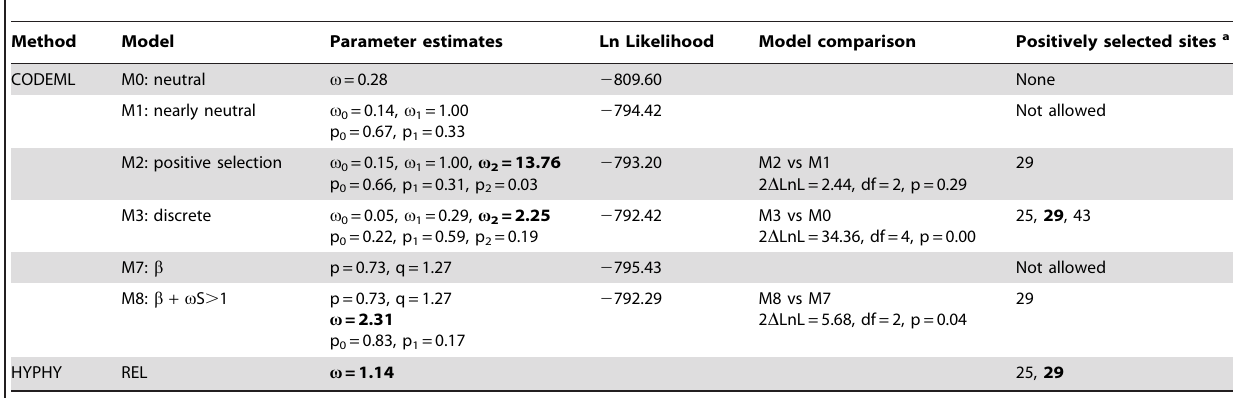
Table 2. Identification of positively selected sites in piscidins by maximum likelihood analysis using various models of evolution.